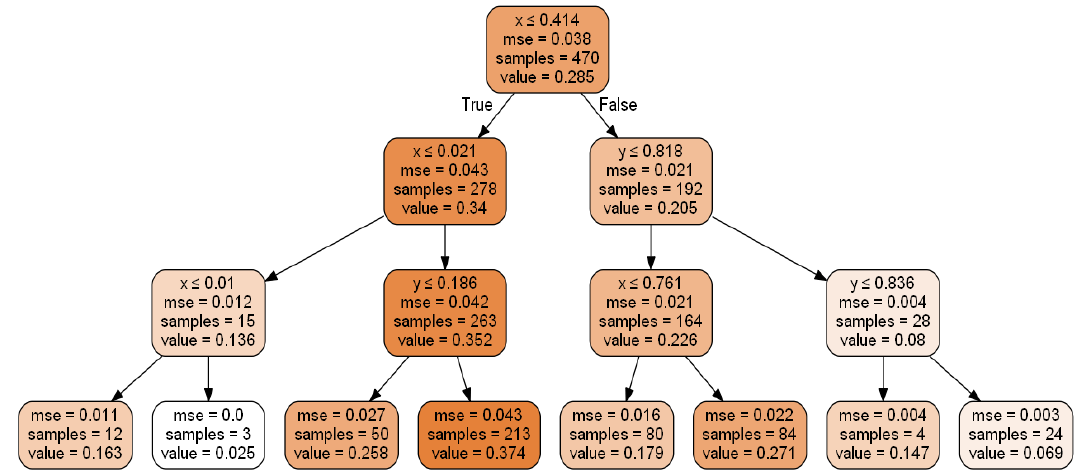
Figure 1. Decision Tree having